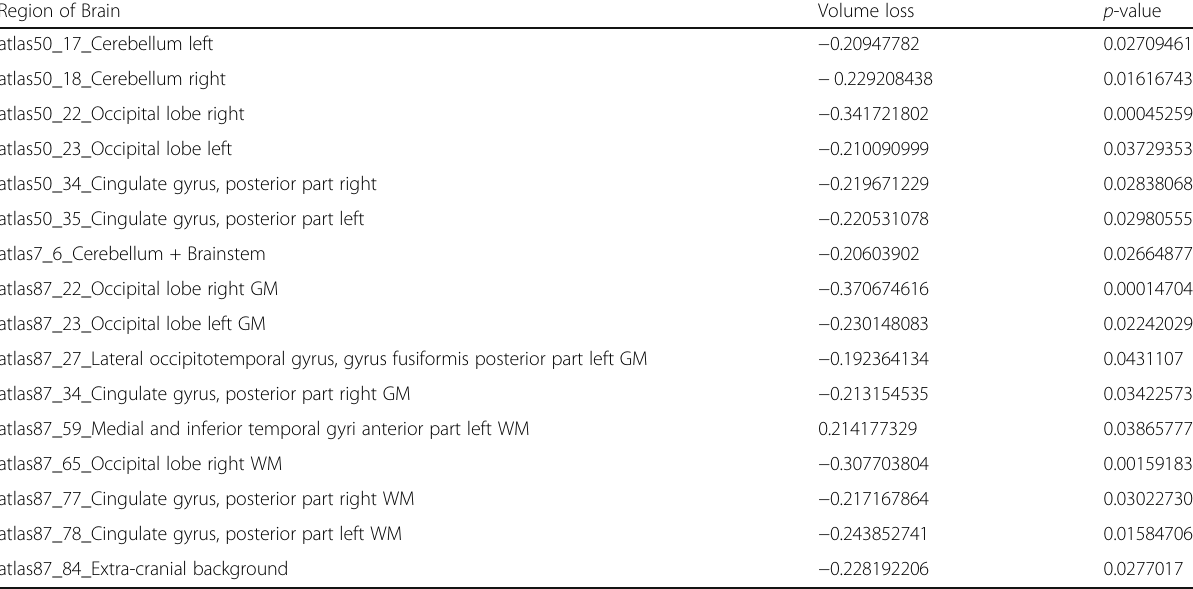
Table 3 Volume loss regions of CHARGE syndrome patients Region of